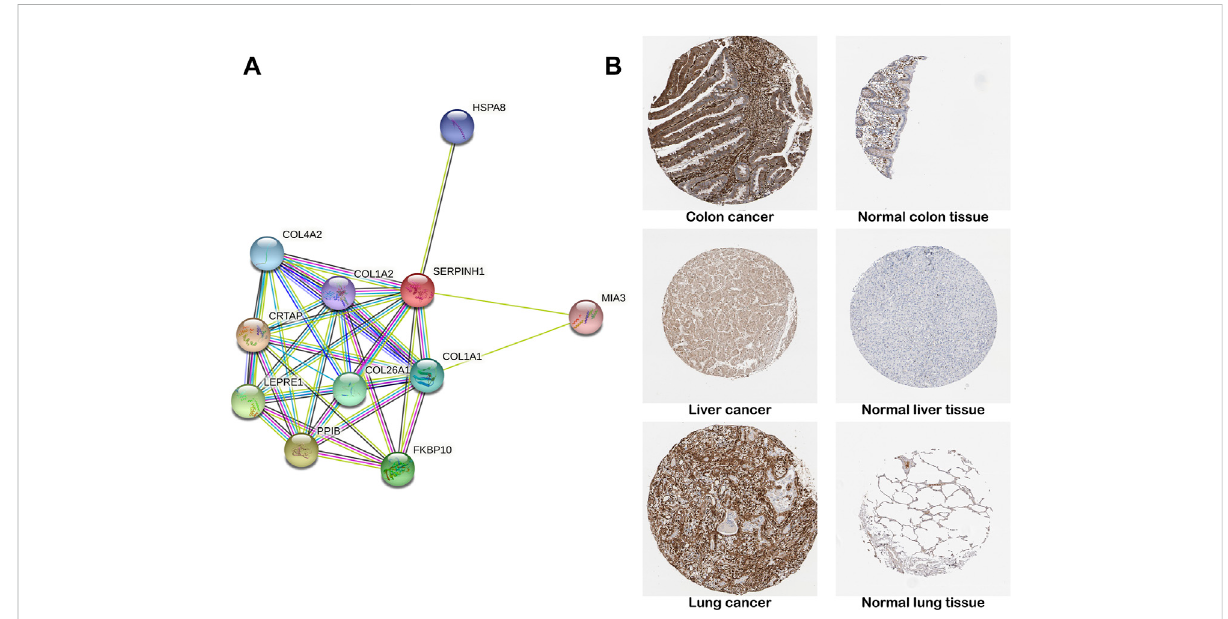
FIGURE 4 PPI network and protein level of SERPINH1. (A) SERPINH1 PPI network. PPI, protein – protein interaction. Each node in the fi gure represents a protein structure. Violet-red indicates from curated databases, copper indicates experimentally determined. Lime, red, and blue represent gene neighborhood, gene fusions, and gene co-occurrence, respectively. Yellow-green indicates textmining; black indicates co-expression, and navy blue indicates protein homology. (B) Representative immunohistochemical staining results of SERPINH1 protein in different tumor tissues and normal